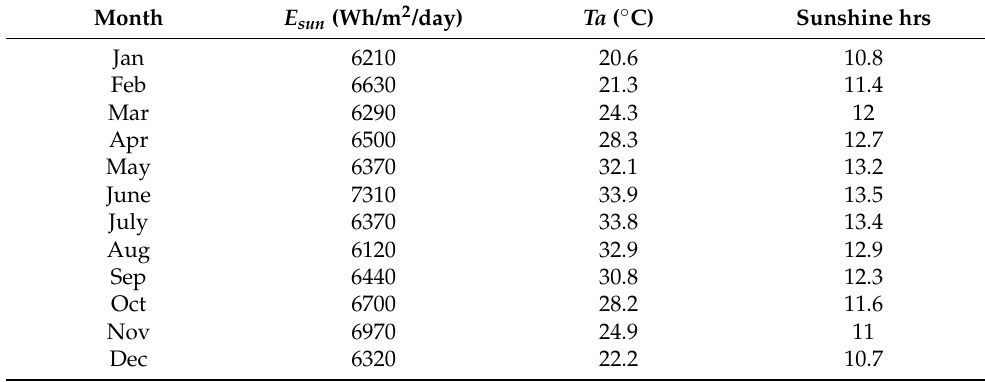
Table 8. Meteorological data.